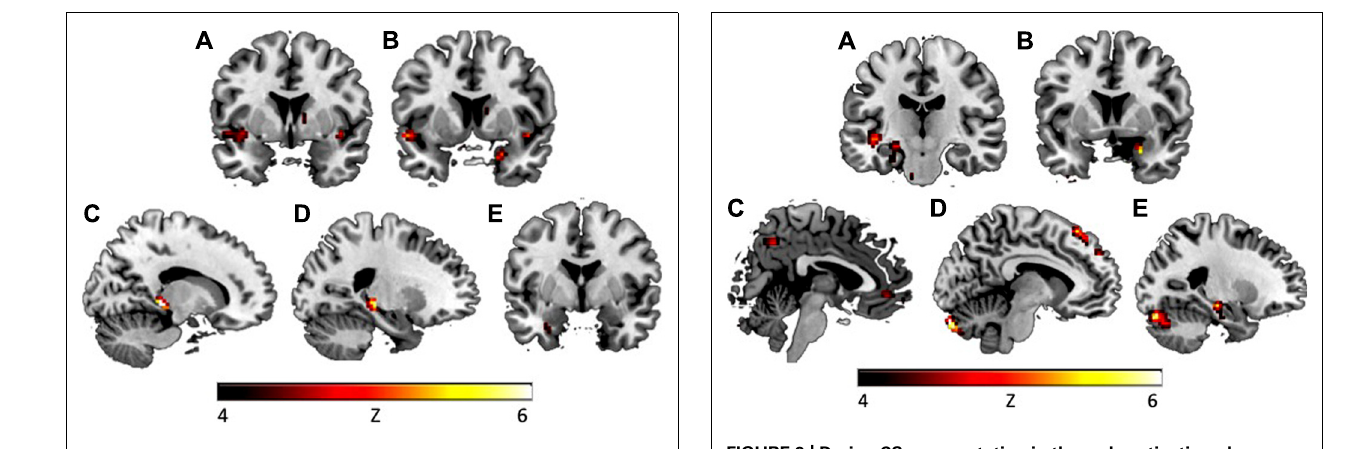
FIGURE 2 | During context presentation in the early extinction phase, CAPS avoidance symptoms were associated with increased activation in (A) left insula ( y = 2) and (B) right amygdala ( y = 7) . During context presentation, CAPS total symptoms were associated with increased activation in (C) right hippocampus ( x = 15), (D) left hippocampus ( x = − 22), and (E) left amygdala ( y = − 1). Activations presented at p < 0.00005. CAPS, clinician-administered PTSD scale.